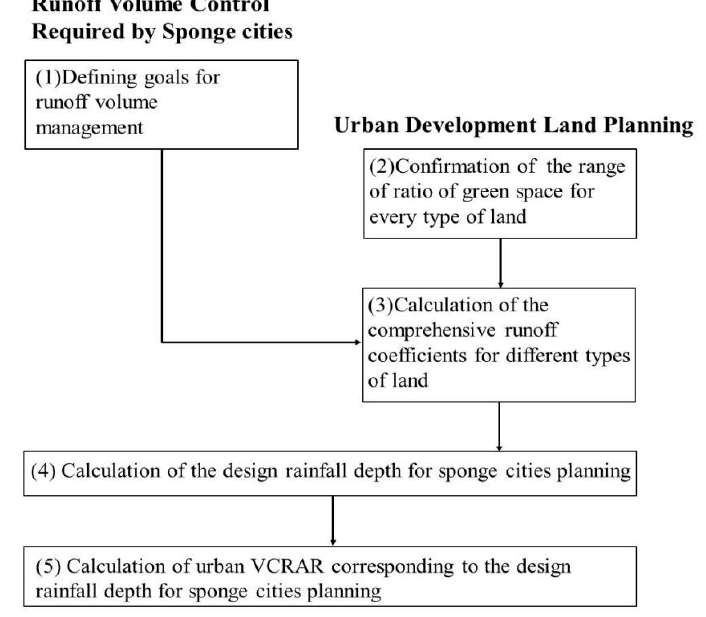
Figure 1. VCRAR calculation model and calculation process.